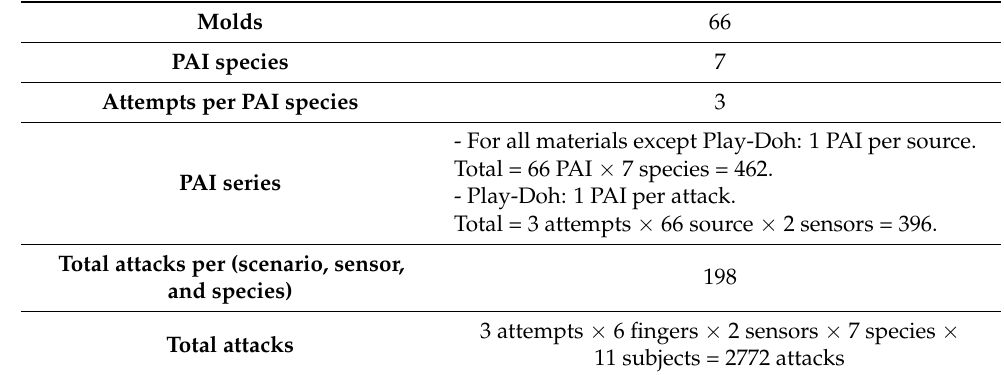
Table 6. Summary of attack sessions per scenario.